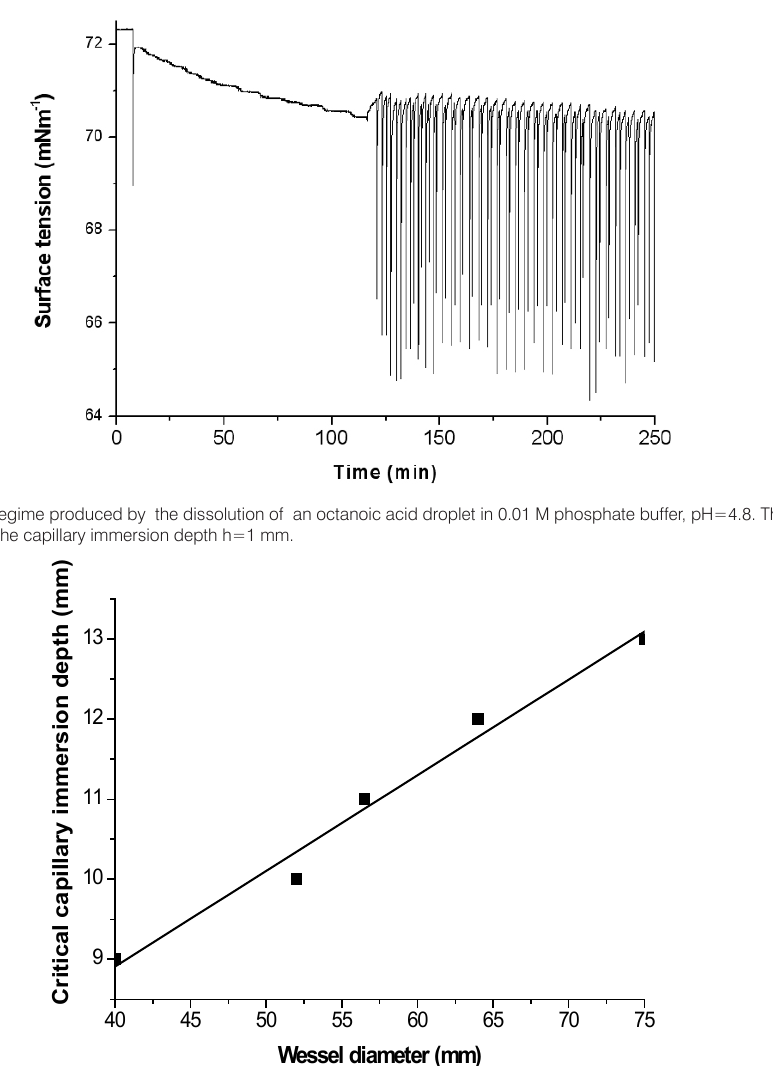
Figure 6. Dependence of the critical capillary immersion depth corresponding to the transition from the oscillaroty regime to the regime of steady convection on the vessel diameter. A heptanol droplet under the air/water surface (reprinted from [34], with permission from